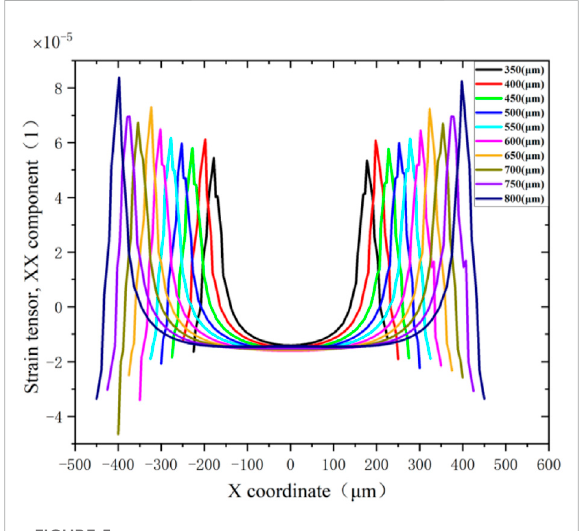
FIGURE 5 Strain situation of different semiconductor